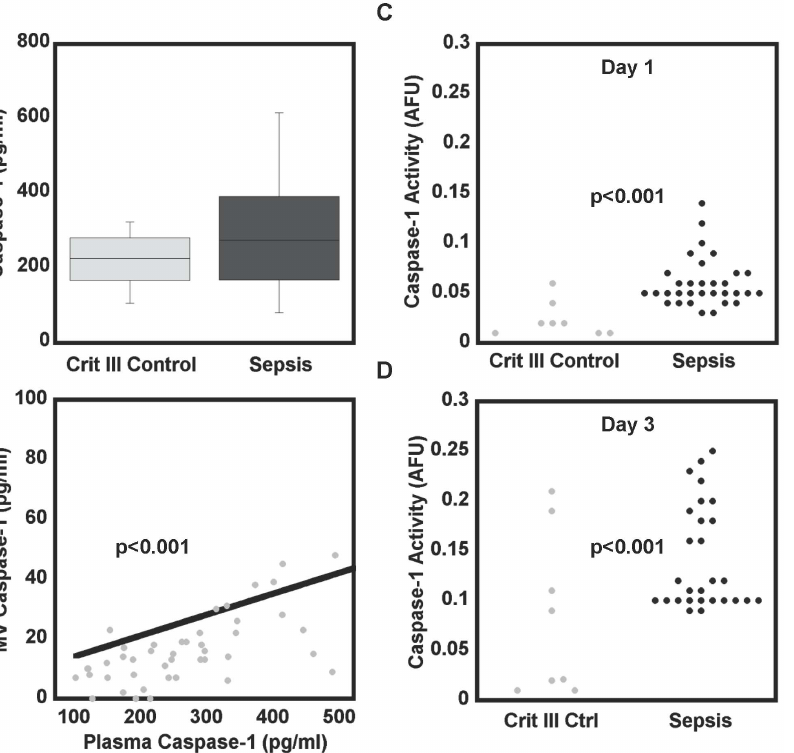
Figure 1. Active caspase-1 is released in plasma microvesicles during sepsis. Plasma samples caspase-1 concentrations between critically ill control patients (n=16) and septic patients (n=34) ( A ). Microvesicles isolated on day 1 show a good correlation between plasma caspase-1 and MV caspase-1 (p , 0.001) ( B ) There was no significant difference between caspase-1 concentrations in plasma and MVs between control patients and septic patients. However, when analyzed for caspase-1 activity there was significantly higher caspase-1 activity on day 1 ( C ) and on day 3 ( D ) between the septic patients and those that were critically ill (p , 0.001 for both days).